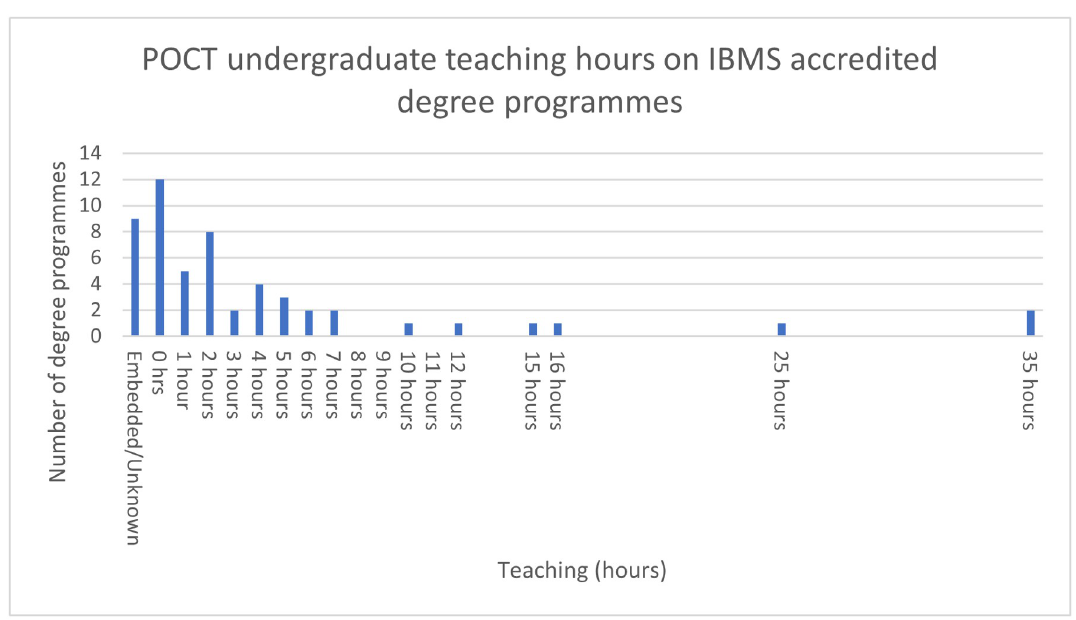
Table 2. Analysis of the 137 point of care testing (POCT) learning outcomes from universities providing institute of biomedical science accredited degrees in the United Kingdom. Is the LO Does the LO describe POCT measurable? specifically?